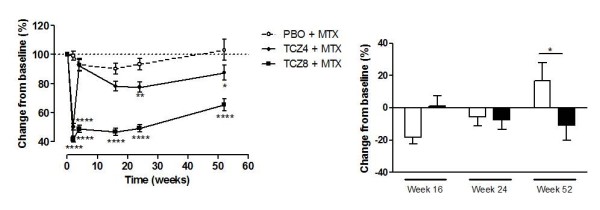
C1M levels in PBO + MTX or TCZ + MTX treated patients. A: Percentage change in C1M levels from baseline in all patients (including patients, who received TCZ). TCZ4, TCZ 4 mg/kg. TCZ8, TCZ 8 mg/kg. B: C1M levels in the subpopulations of the PBO group. Non-escape Week 16 n = 86, escape Week 16 n = 81. Non-escape Week 24 n = 79, escape Week 24 n = 78, non-escape Week 52 n = 66, escape Week 52 n = 56. Values are depicted as mean + SEM. Two-way ANOVA test was used to test for differences. Significant levels: *: P <0.05, **: P <0.01, ****: P <0.0001. C1M, Type I collagen degraded by MMPs; MTX, methotrexate; PBO, placebo; TCZ, tocilizumab